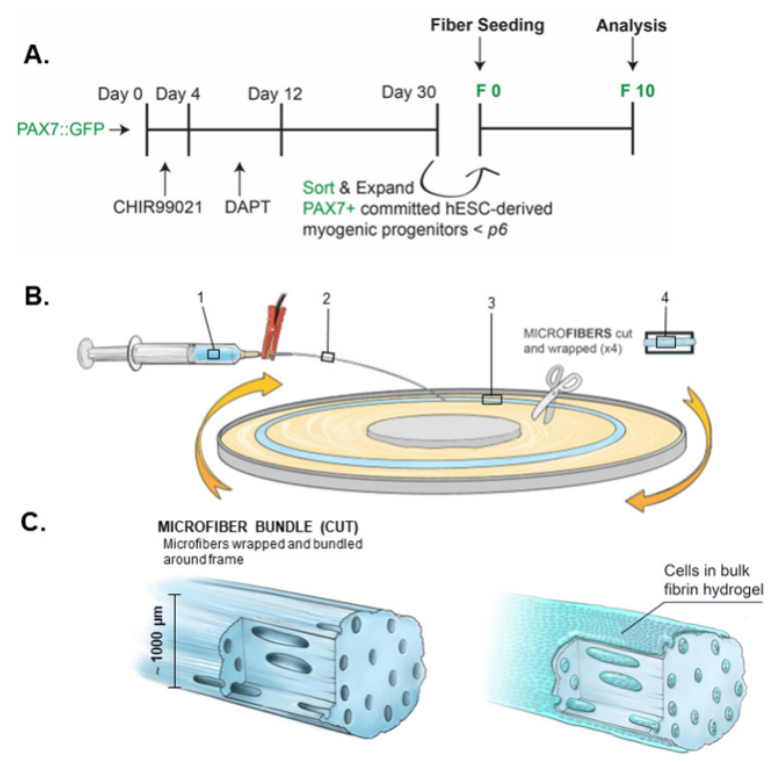
Figure 1. Induction of hPDMs from pluripotent stem cells and seeding onto fibrin microfiber bundles. ( A ) Timeline of myogenic commitment of hPSCs and fiber seeding. ( B ) Hydrogels are loaded into syringes and voltage applied across needle tip (1) resulting in a continuous stream of extruded hydrogel (2). Fiber is formed on a rotating flatform (3), then spun onto a frame (4). ( C ) Resulting fibers are approximately 1000 µm. Cells were also seeded in bulk hydrogel onto microfiber bundles.